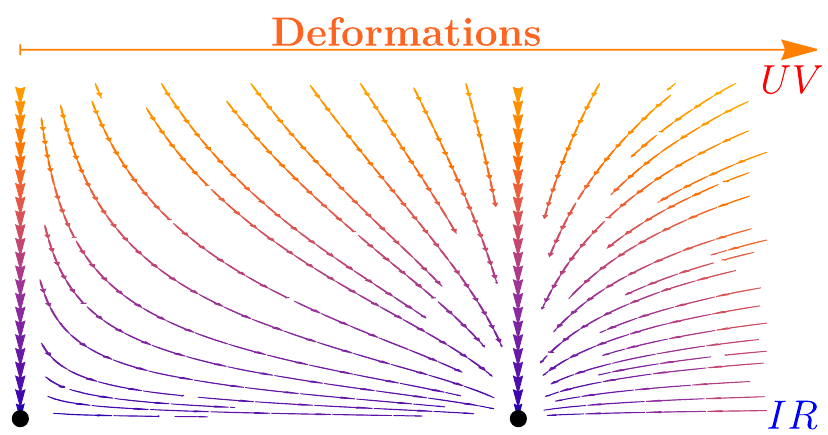
Figure 1 . Illustration of stable and unstable fixed points in the RG